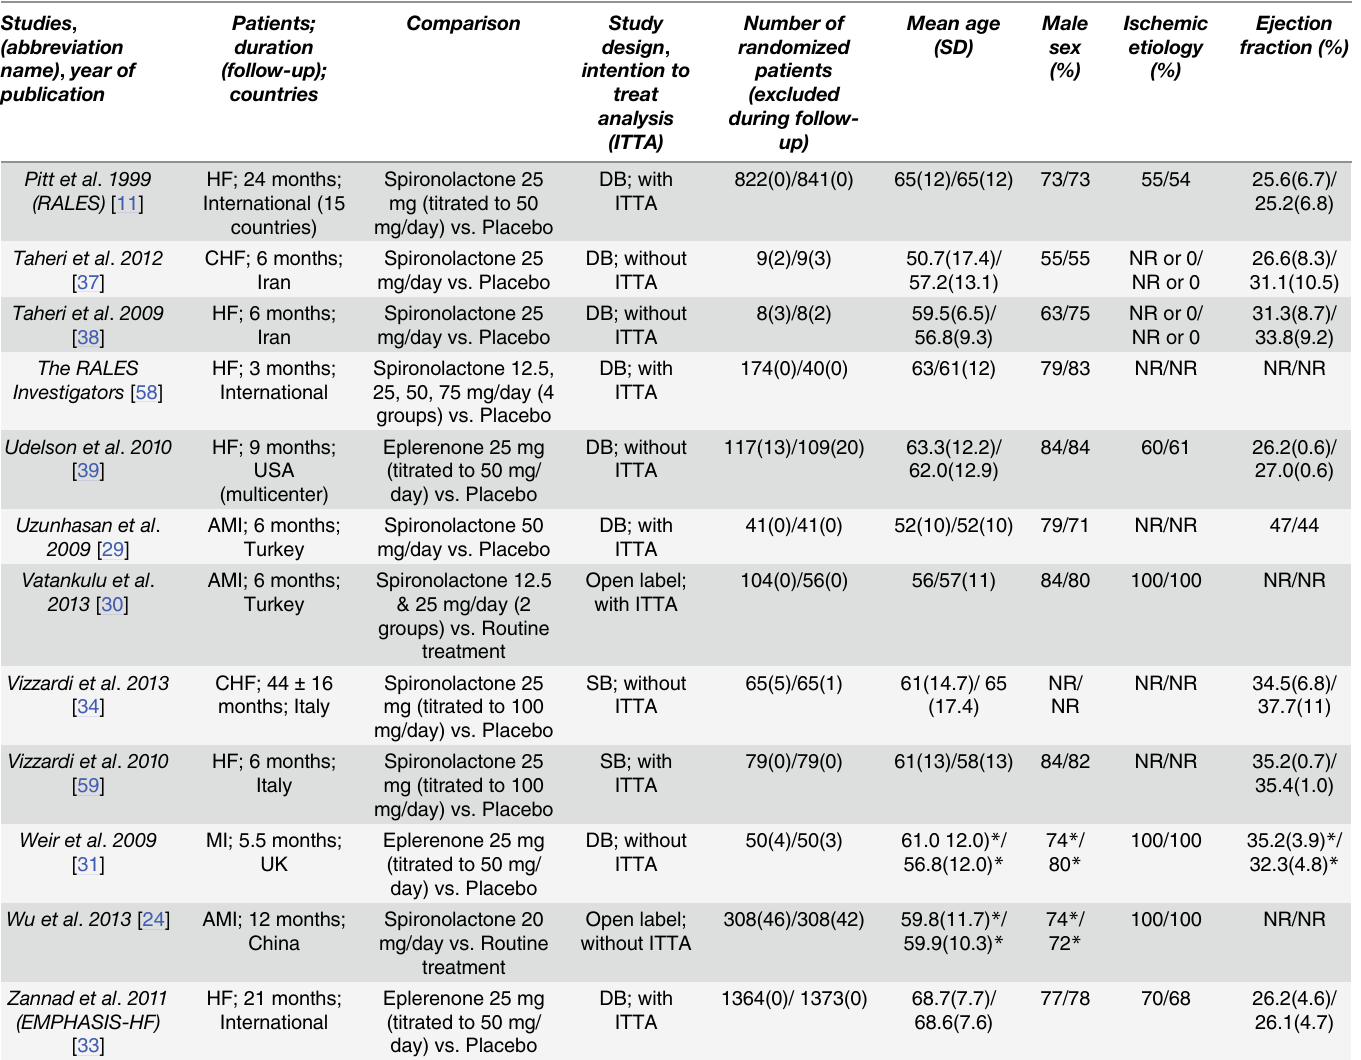
follow-up duration, the SCD rate in HF patients was 4.89% (n = 202/4132) in those treated with AAs, compared with 6.09% (n = 254/4169) in those treated with placebo/control. In post- MI patients, SCD was reported only in the EPHESUS trial [13] at the rates of 4.88% (n = 162/ 3319) and of 6.07% (n = 201/3313) in groups receiving AAs and placebo,